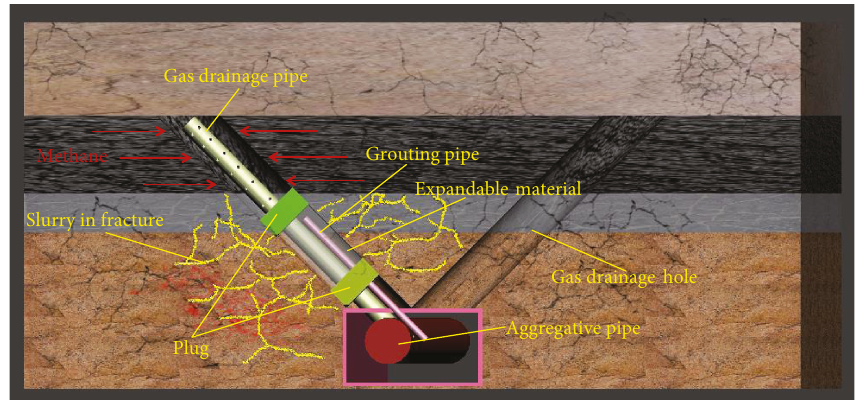
Figure 1: Schematic of sealing gas drainage boreholes using expandable material with high water content.